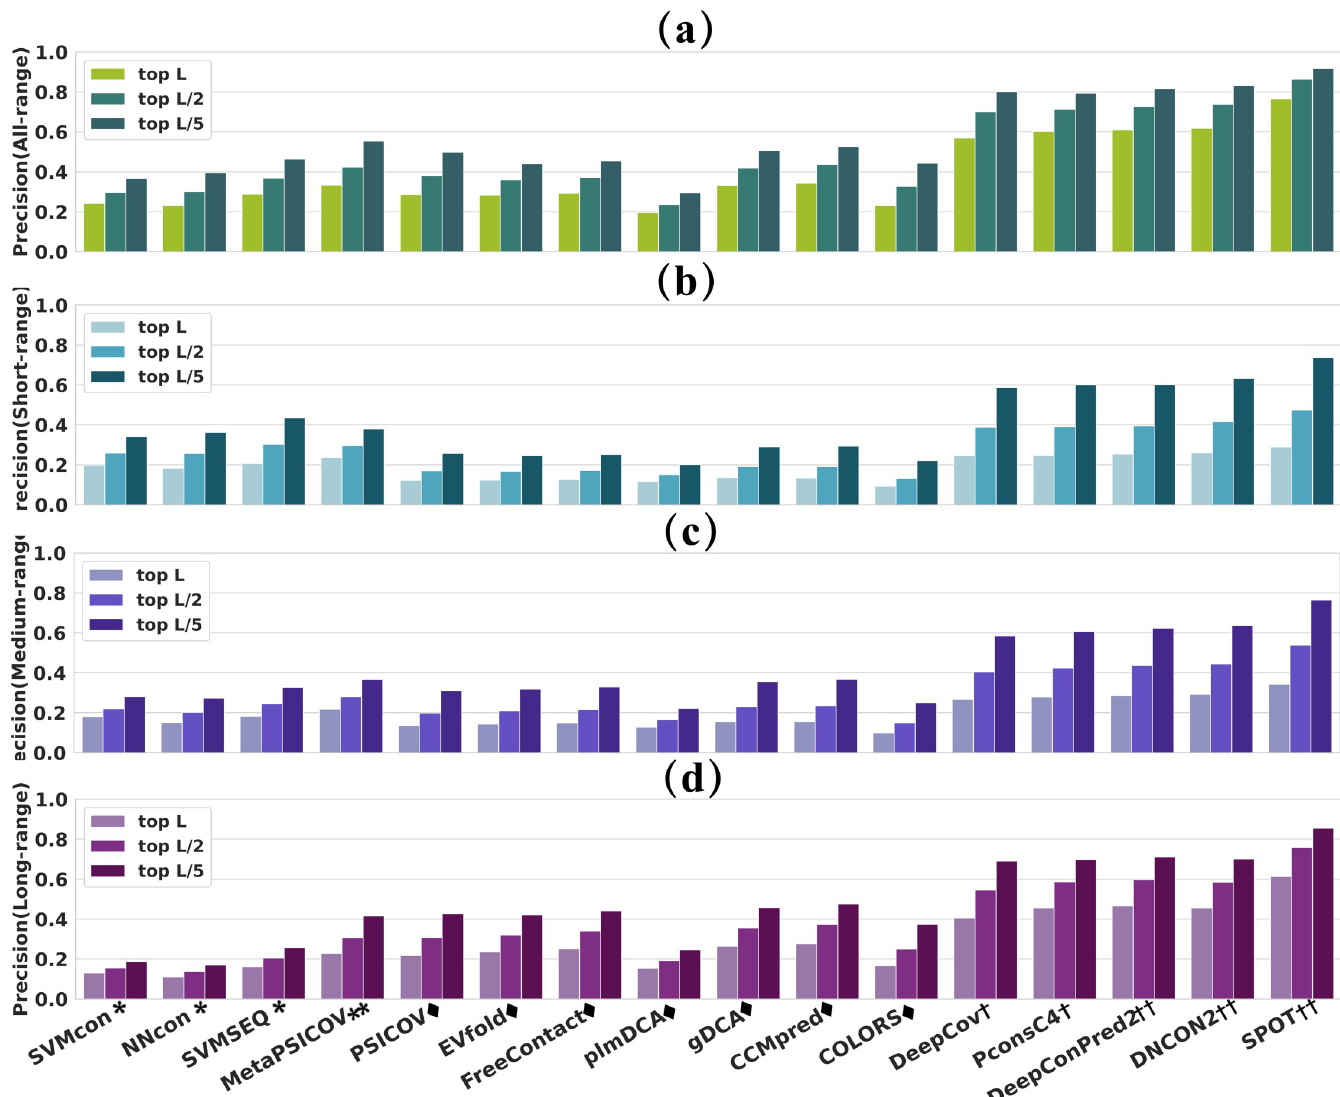
Fig 1. The overall prediction precision on TestSet1 for (a) short-range (b) medium-range and (c) long-range residue contacts . Superscripts � , �� , ◆ , † and †† represent method categories of traditional-ML, consensus-ML, ECA, single-input DL and multi-input DL. DL methods significantly outperform ML and ECA methods. In particular, SPOT achieves the highest precision, outperforming SVMSEQ (the top traditional-ML method), MetaPSICOV (consensus-ML method) and CCMpred (the top ECA method) by 45.3%/59.8%, 36.5%/44.0% and 39.2%/ 38.0% for top L/5 long-/all-range predictions.